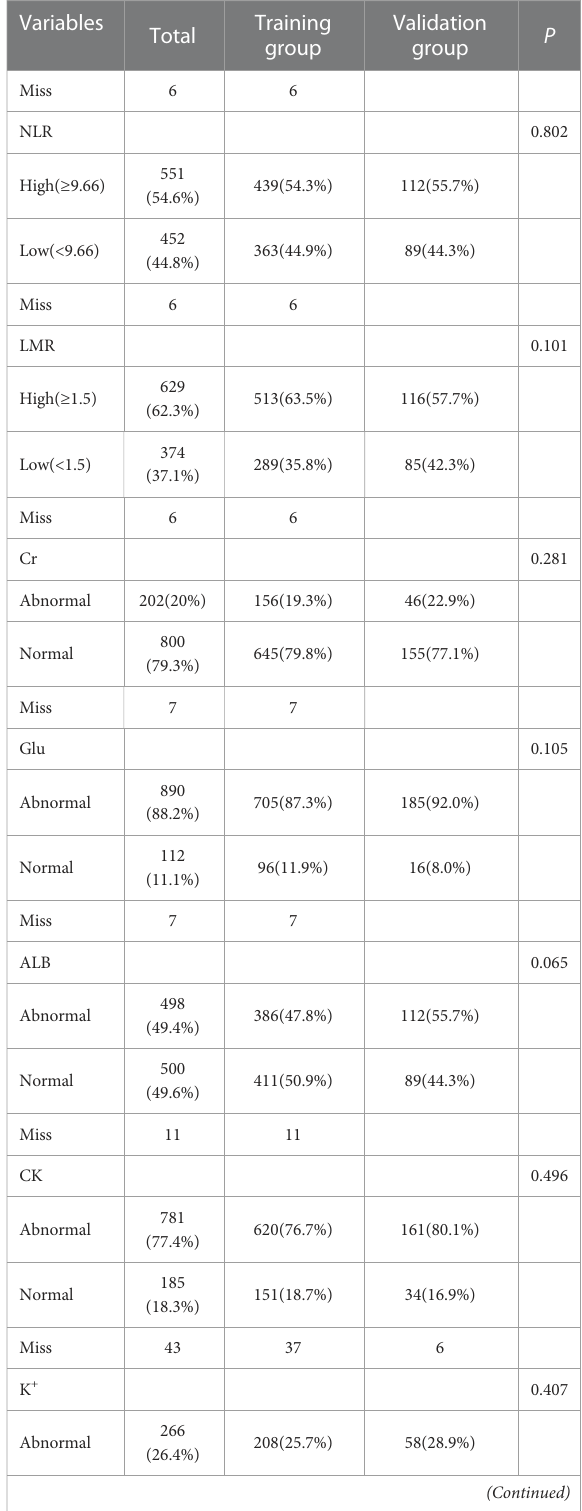
TABLE 4 Clinical characteristics of the training group and the external validation